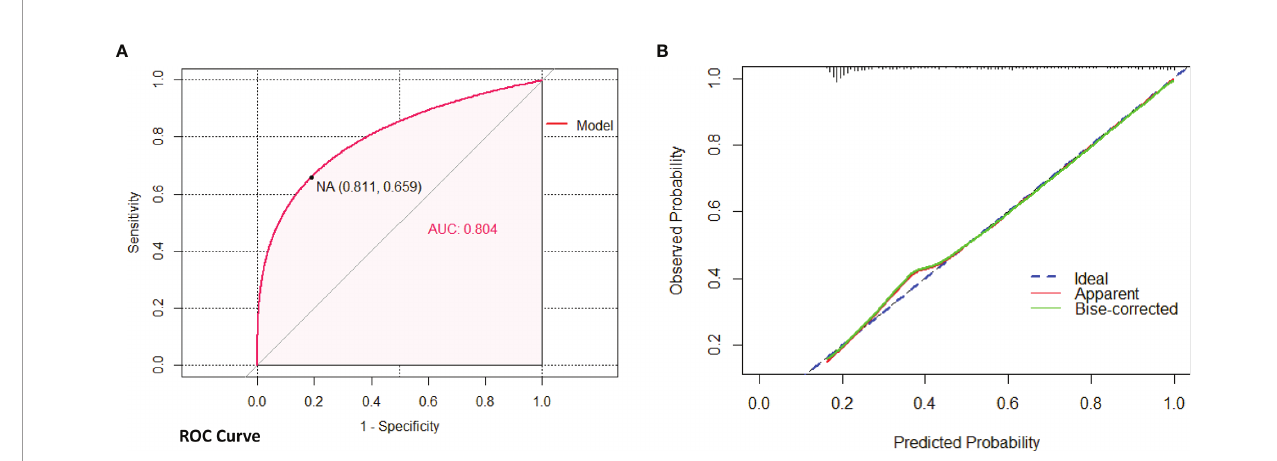
FIGURE 2 | Internal validation of nomogram (PCa) in the KD cohort by bootstrap method (500 resamples). (A) Discrimination of the nomogram was evaluated by the ROC curve; AUC=0.804 which is equal to a c-statistic. (B) Calibration curves illuminate the agreement between the predicted risks of PCa and the observed incidence of PCa. The blue dotted line represents an ideal fl awless